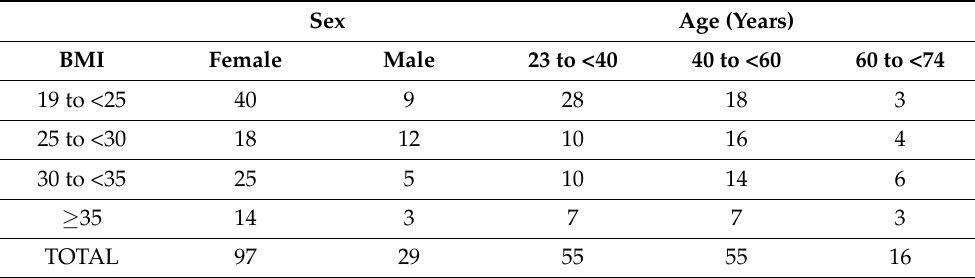
Table 1. Cohort BMI, sex, and